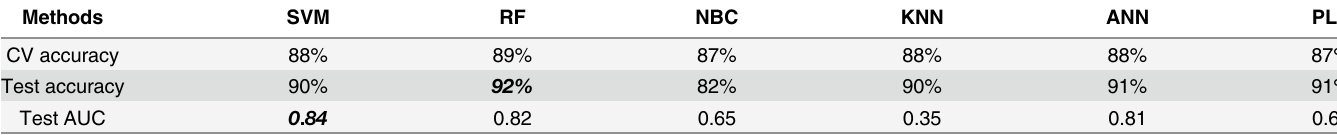
Table 10. Non-redundant ddG binary classification (training and test data sets were selected by protein).